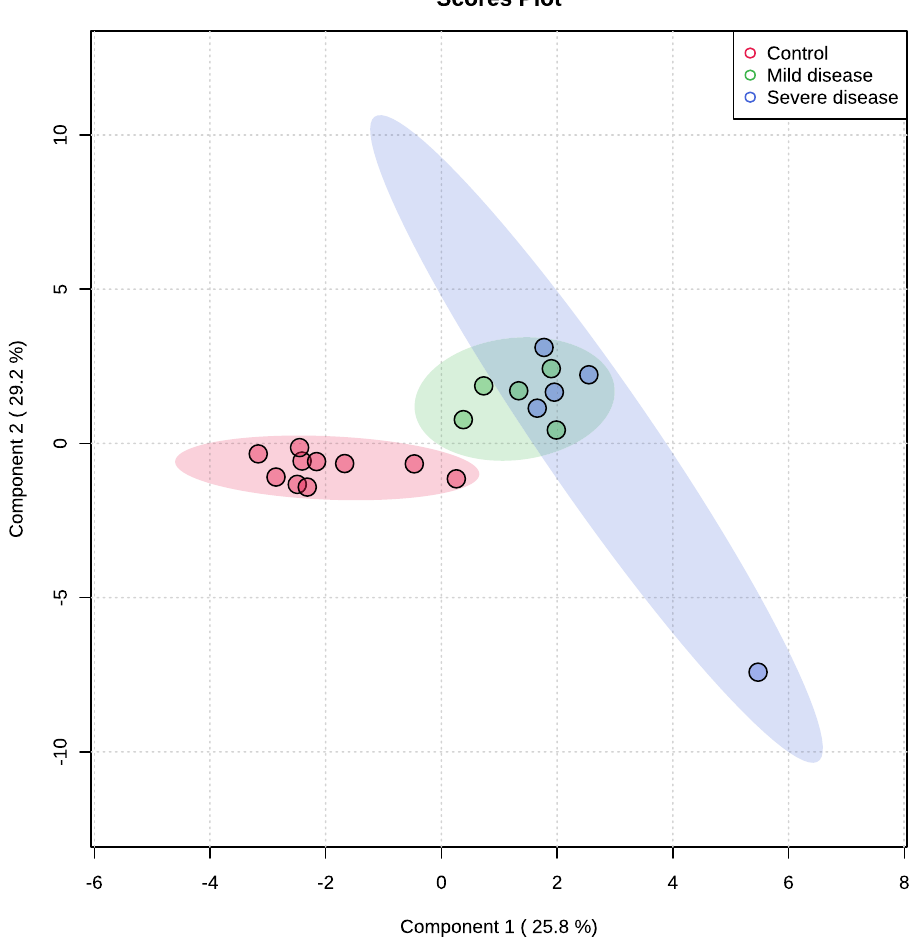
Figure 7. Partial least square-discriminant analysis (PLSD-DA) in patients with different COVID-19 severity and controls. Each point in the plot corresponds to a saliva sample. Source: Metaboanalyst 5.0 (https:// www. metab oanal yst.